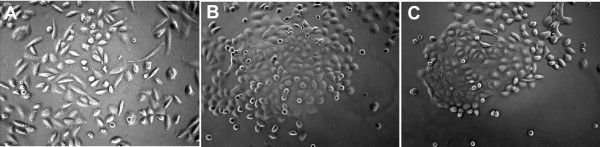
Morphology (×100) of the DU145 and DU145-Id4 cell lines in culture. (A) Parental DU145 cells show a more mesenchymal morphology that is long and spindle shaped. (B & C) The DU145-Id4 cells appear more like epithelial cells that tend to adhere to each other hence appear as clusters. The DU145-Id4 cell line shown above is at passage 28.